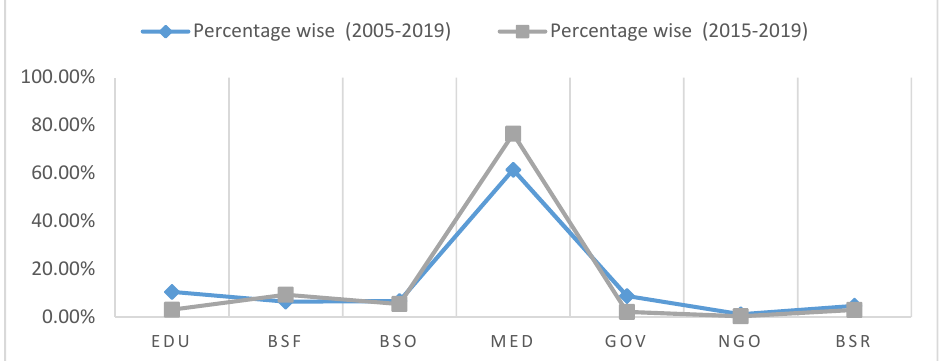
Figure 1. Representation of Data Breach Incidents.